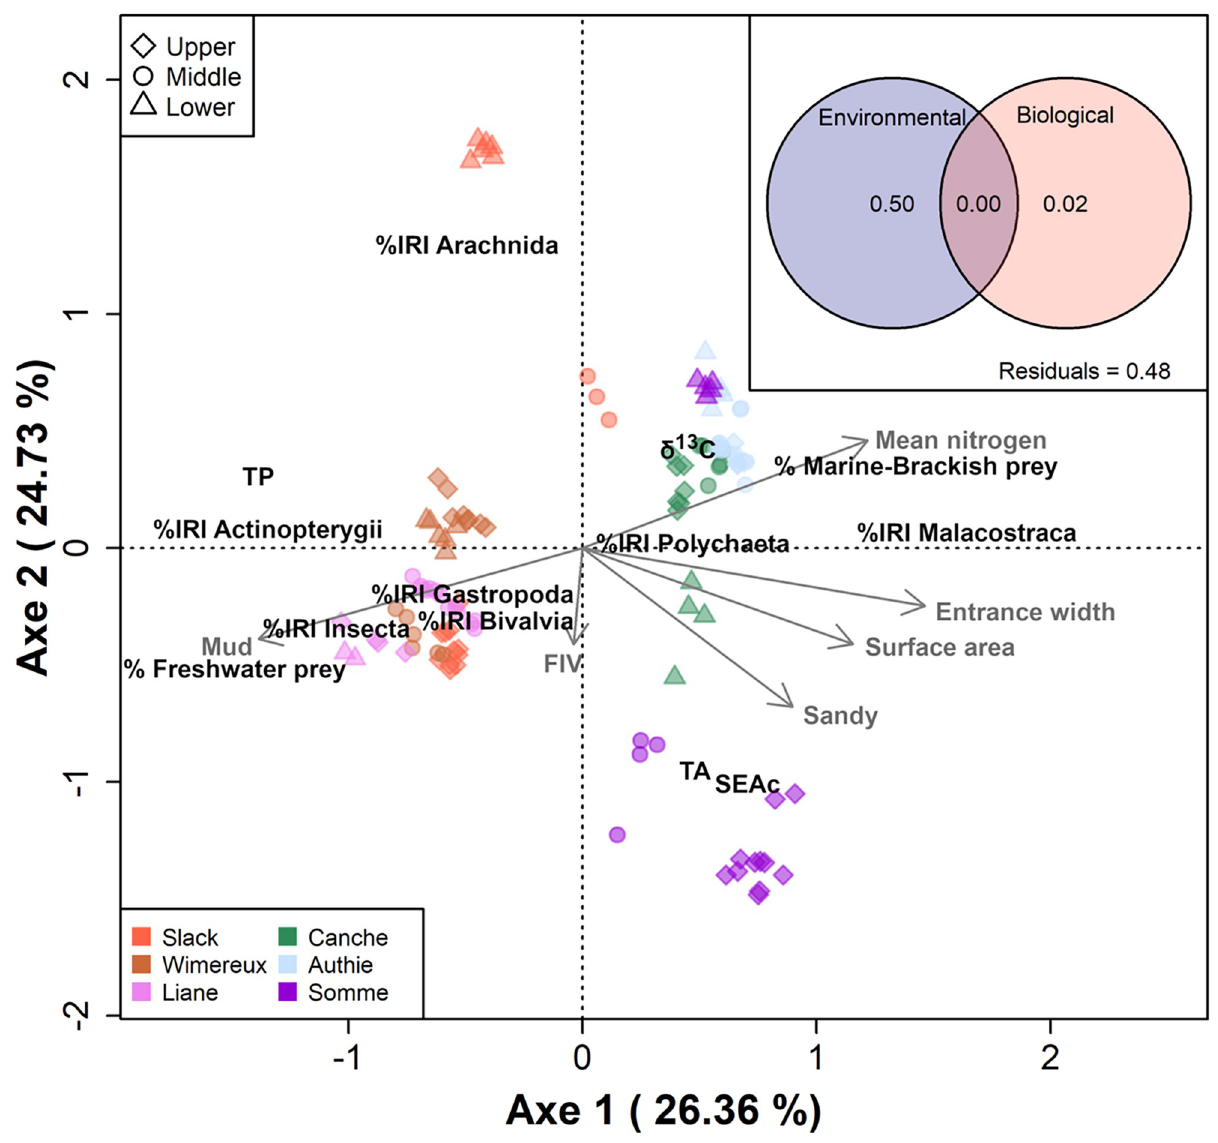
Fig 4. Redundancy and variance partitioning (top-left) analyses on the dietary (index of relative importance (%IRI) of prey categories (see Table 2), and percentage of marine-brackish and freshwater prey) and isotopic niche ( δ 13 C, total convex hull area (TA), corrected standard ellipse areas (SEAc), and trophic position (TP)) of European eels along salinity gradient (i.e. lower, middle and upper) in the six estuaries constrained by selected biological structures of eel (silvering stages: FIV female migrating phases) and environmental variables (surface area, sediment types, entrance width and mean total nitrogen). Numbers in the circles (top-left) represent the proportion of variance explained by each co-variable.